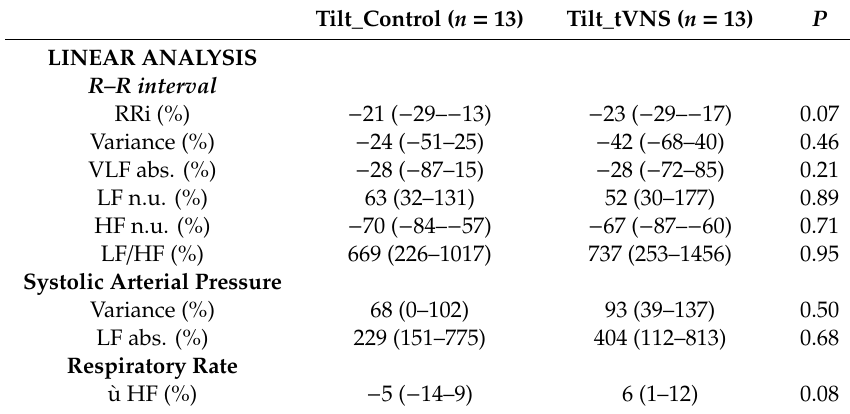
Table 4. Response ( Δ %) of cardiac and peripheral autonomic control evaluated by a linear method using an autoregressive model.